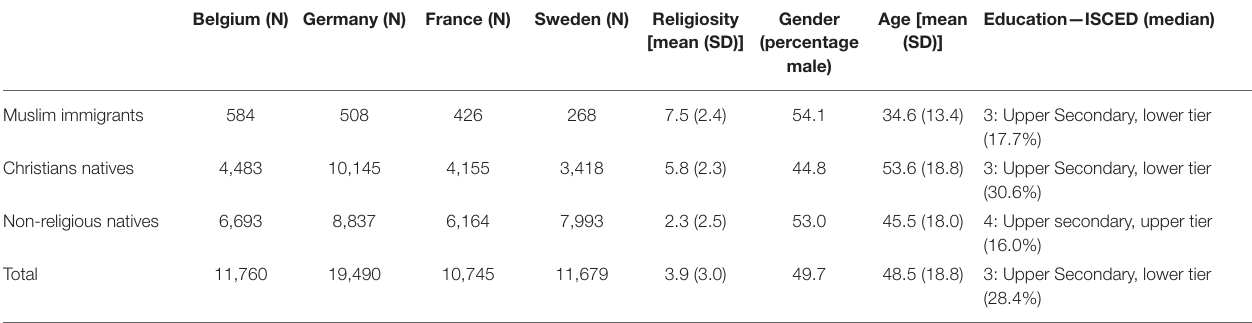
TABLE 1 | Number of cases and